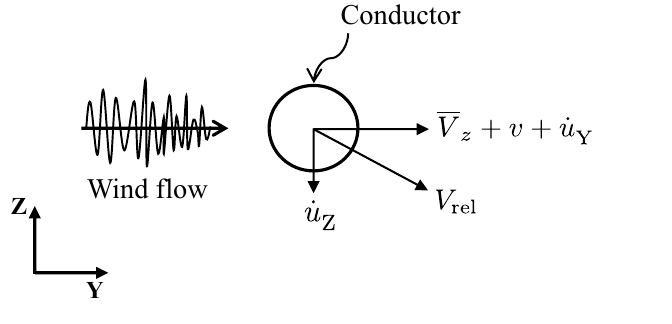
Figure 5. Conductor-wind relative